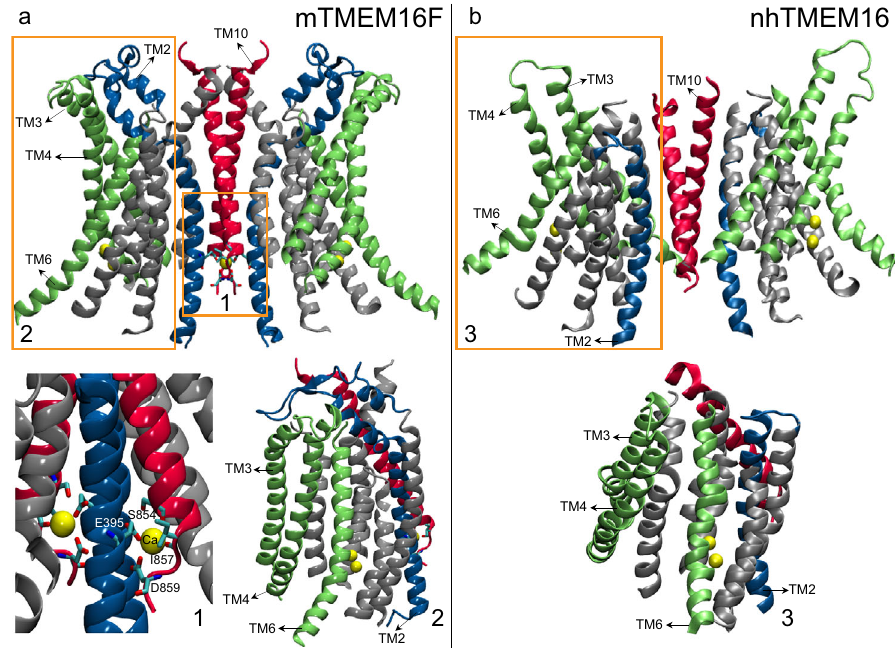
Fig. 1 Distinguishing structural motifs of the TMEM16F PLS are highlighted by a comparison of mTMEM16F (PDBID 6QP6), in Panel a ( left ) and nhTMEM16 (PDBID 6QM9) in Panel b ( right ). Most of the intracellular and extracellular loop regions have been removed for clarity. In a , rectangle 1 highlights the third (distal) Ca 2 + binding site at the dimer interface of mTMEM16F. Shown in licorice and labeled are the 4 residues coordinating the Ca 2 + ion in its binding site (E395 on TM2, and S854, I857, and D859 on TM10). Rectangle 2 in a and Rectangle 3 in b highlight the groove regions in mTMEM16F and nhTMEM16, respectively. Shown are TMs 3, 4, and 6 (in green) lining the groove region, TM10 (in red), and TM2 (in blue). Note that the linker region connecting TMs 1 and 2 in the mTMEM16F model reaches towards the groove region and is positioned close to the extracellular end of TM4 helix (see also Fig.